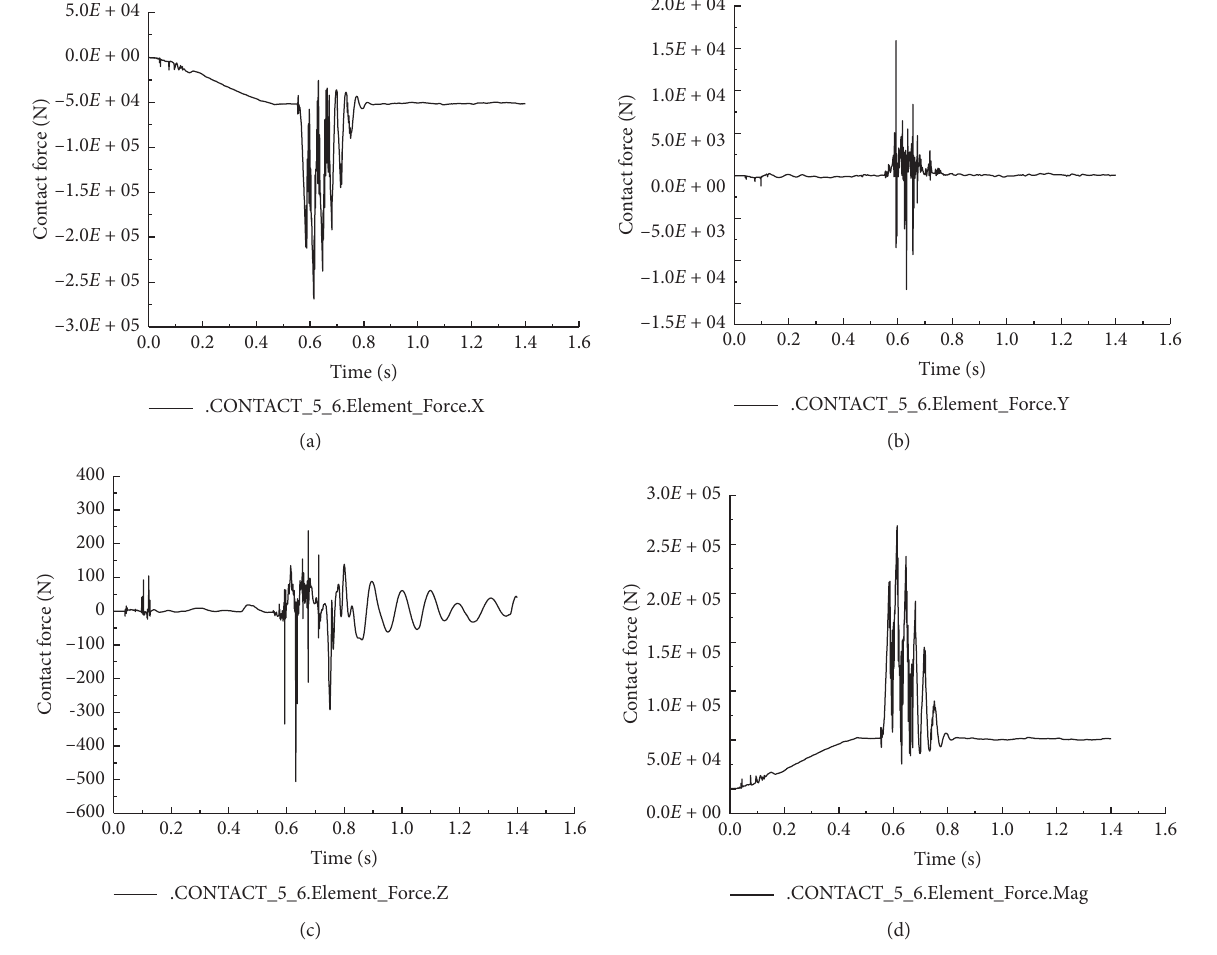
Figure 9: Change of indirect contact force of the chain link under impact load. (a) X component of the contact force. (b) Y component of the contact force. (c) Z component of the contact force. (d) Contact force resultant